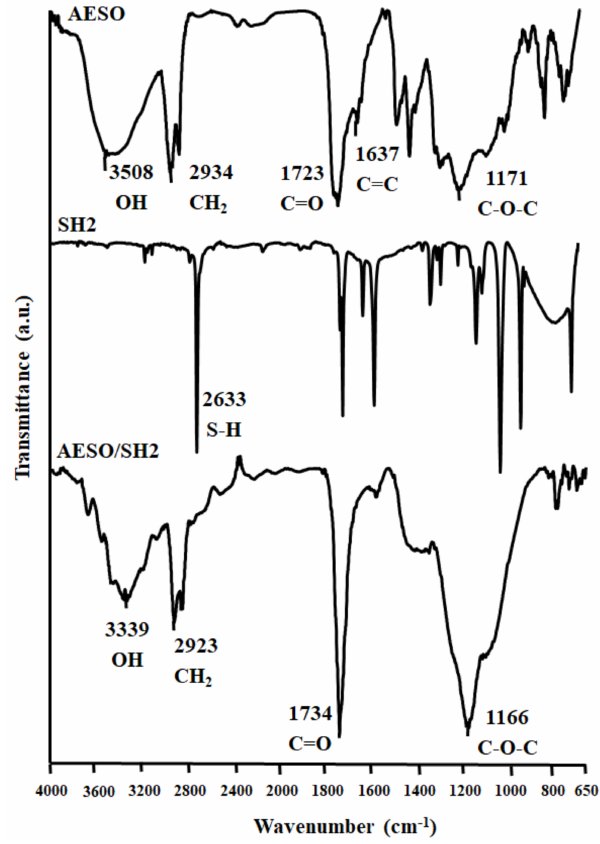
Figure 1. IR spectra of acrylated epoxidized soybean oil (AESO), 1,3-benzenedithiol (SH2), and cross-linked polymer AESO/SH2.